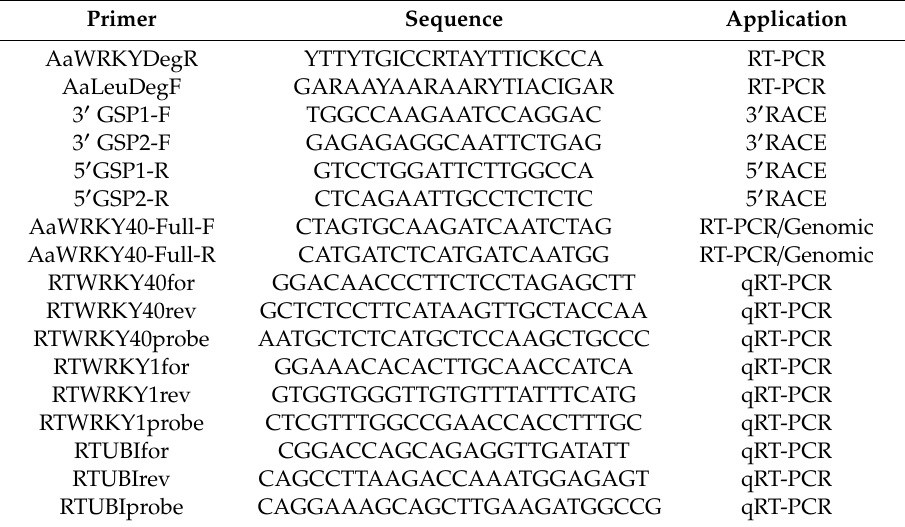
Table 3. Primer nucleotide